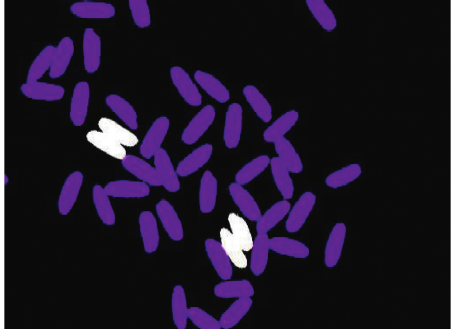
Figure 26: Fully convolutional neural network segmentation.